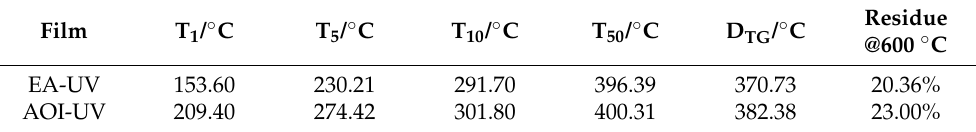
Table 1. Thermal weight loss test results of two high refractive index UV cured films.